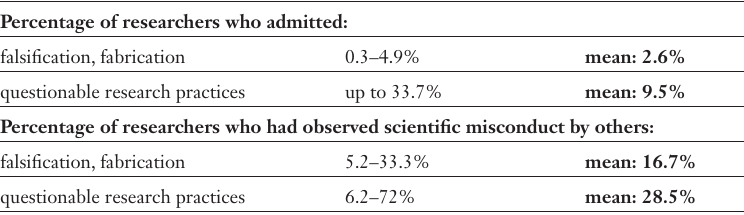
Incidence of scientific misconduct admitted or observed: meta-analysis of 18 surveys in different scientific disciplines [6]. Percentage of researchers who admitted: falsification, fabrication